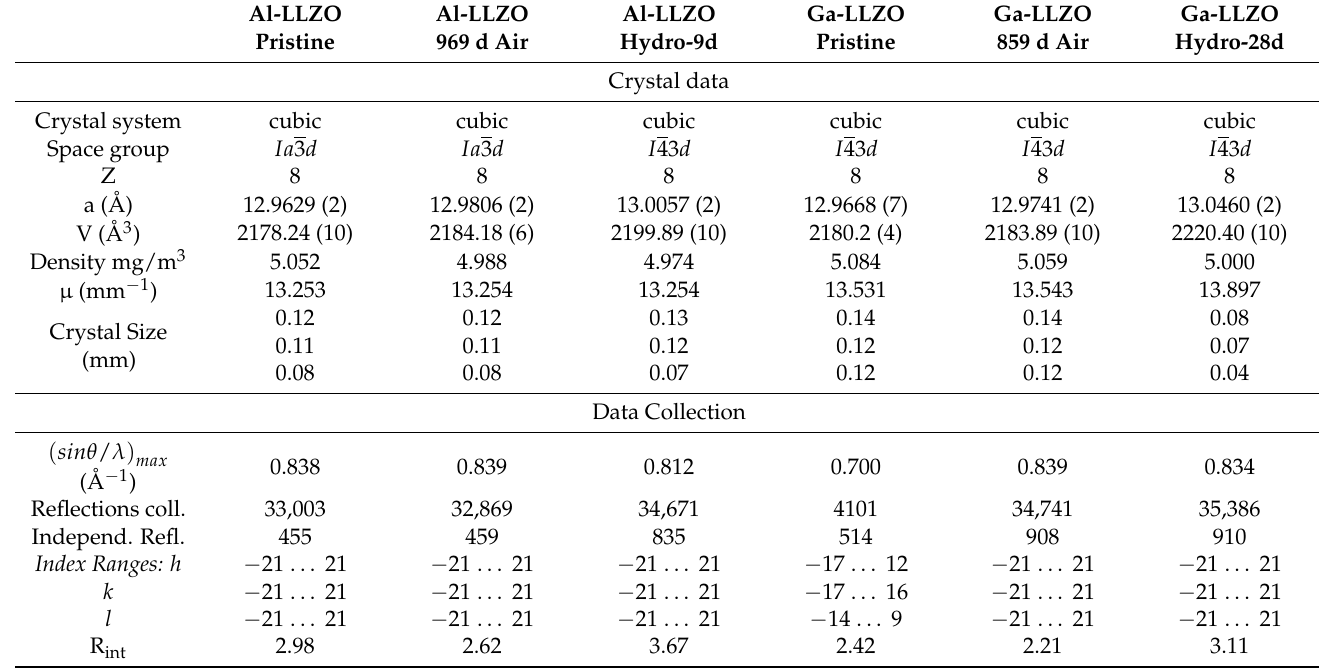
Table 2. Experimental details and refinement results of X-ray diffraction data of selected stabilized LLZO single crystals; Experiments were carried out with Mo K α —Radiation and λ = 0.71073 Å using a Bruker Smart Apex 3-circle diffractometer. Full-matrix least-square refinement of F 2